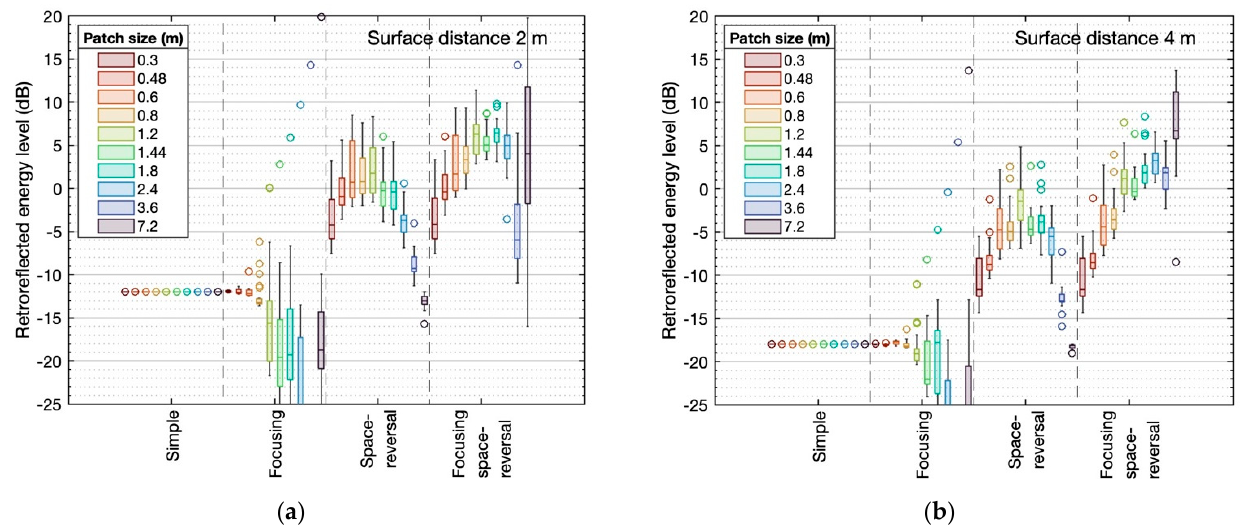
Figure 5. Distribution of retroreflected energy levels for 25 collocated source-receivers. The reflector is a 7.2 × 7.2 m square, and 24 source-receivers are in a 2.4 × 2.4 m square centered on the reflector at ( a ) 2 m or ( b ) 4 m distance. One source-receiver is at the focus of a 3.6 m patch on the same plane, beyond the 2.4 × 2.4 m square. Values are speech-A-weighted.